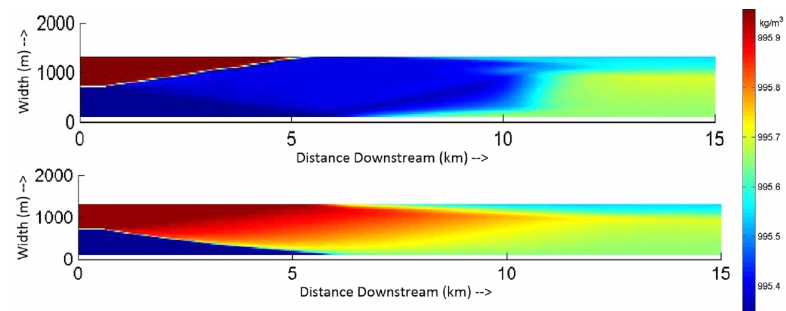
Figure 8. Densities in the top and bottom layer in the case with half the width, such that the width becomes restrictive.